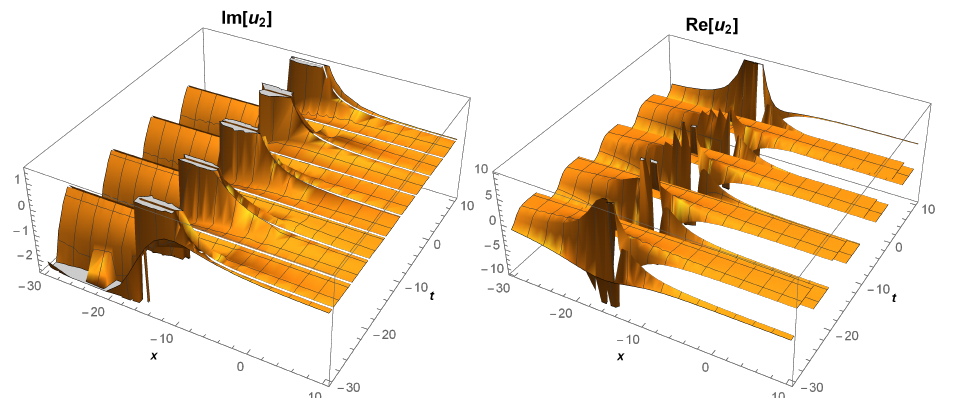
Figure 4. The 3D figures of Equation